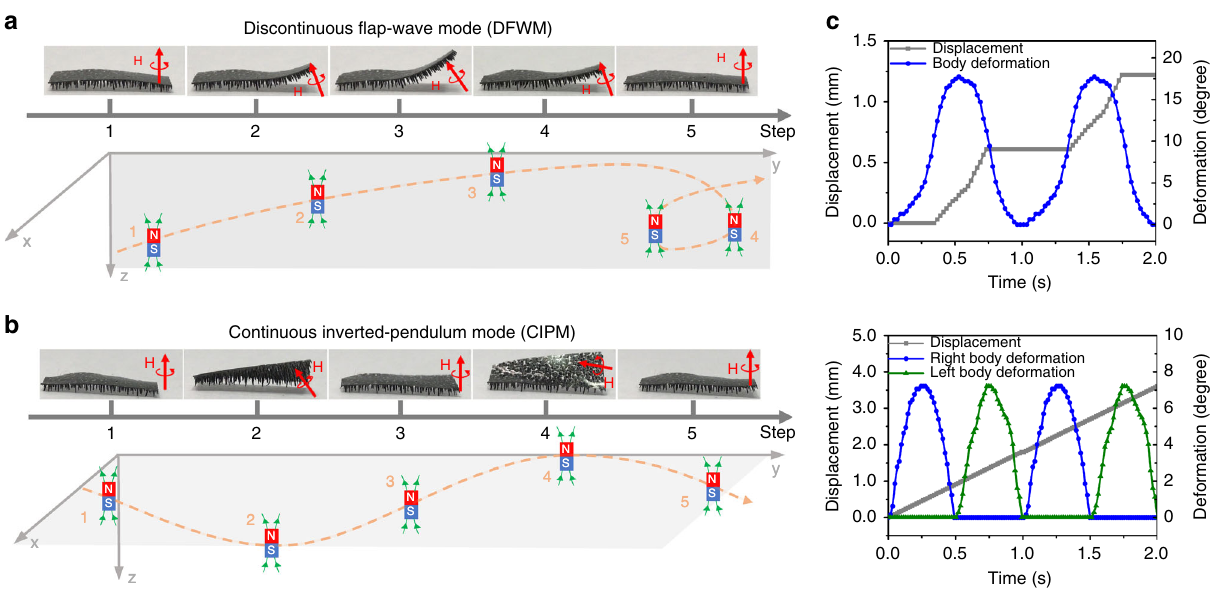
Fig. 2 Two different locomotion modes. a Discontinuous fl ap-wave (DFW) locomotion under the application of an “ O ” shape magnetic fi eld in the “ y – z ” plane, under which the robot shows a “ stick-slip ” locomotion. As the magnetic bar is moved upper and forward, the robot raises its body corresponding to the front feet alignment to the magnetic fl ux. At the same time, the robot moves forward one step under the pulling force along the y axis. After the external magnetic fi eld is off, all the robot ’ s feet are in touch with the ground again. Such a fl ap-wave locomotion is similar to a typical “ stick-slip ” movement widely used in piezo actuation at micro/nano scale. b Continuous inverted-pendulum (CIP) under the driving of an “ S ” shape magnetic fi eld on “ x – y ” plane, under which the robot shows a “ bipolar ” locomotion-like human walking. The magnetic bar is programmed to move to the left and right directions alternately, meanwhile maintaining a forward movement. In response to the magnetic fl ux, the robot exhibits a continuous locomotion-like human walking, characterized by the alternate rise-up and continuous forward motion. c The robot ’ s step size at the CIP mode (277% feet length) is around three times longer than that at the DFW mode (94% feet length) in each gait cycle. It indicates that the CIP locomotion has a higher locomotion ef fi ciency than that of the DFW, mainly because the robot can switch twice in one gait cycle continuously at the CIP mode, whereas only once at the DFW